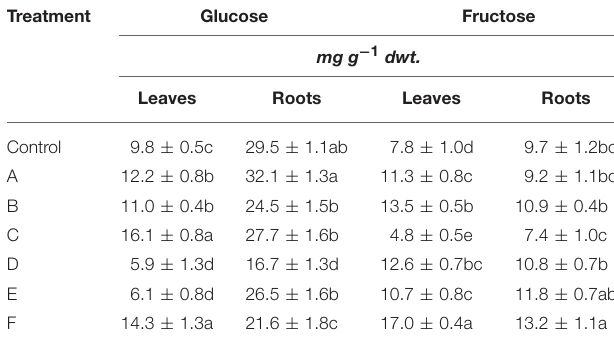
Data represent the means of five measurements per treatment ( ± std). Different letters along the same column indicate significant differences between treatments (p < 0.05) according to Student-Newman-Keuls